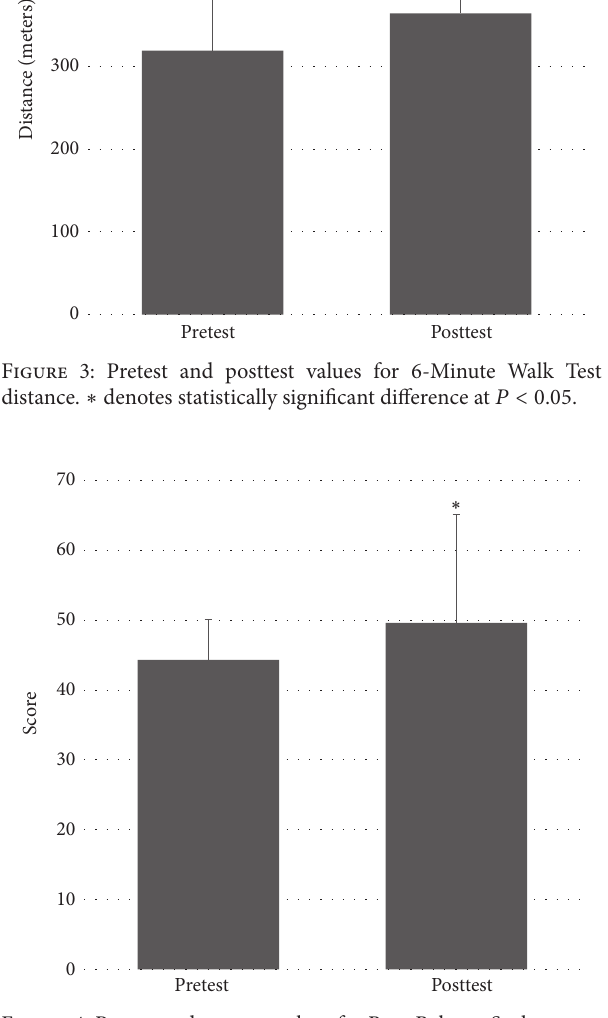
Figure 4: Pretest and posttest values for Berg Balance Scale scores. ∗ denotes statistically significant difference at 𝑃 < 0.05 .